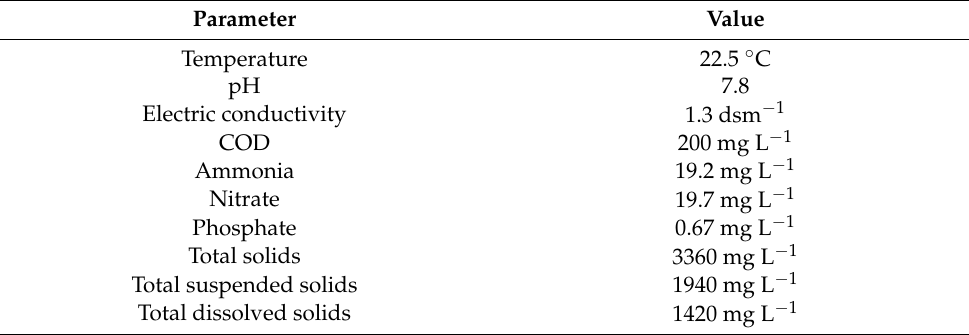
Table 2. Initial characterization of wastewater